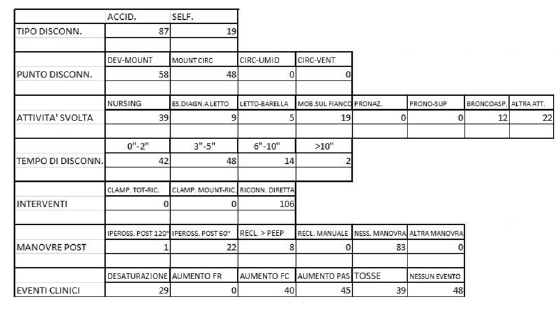
Table 2 (abstract A167). Sezione specifica, statistiche delle disconnessioni non